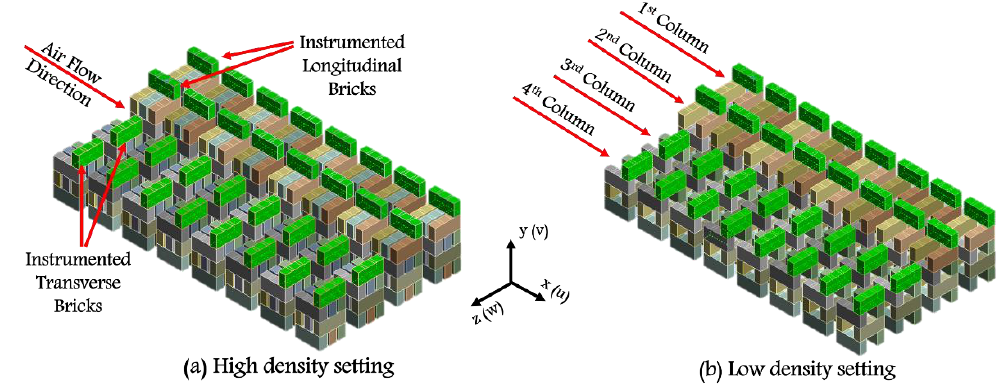
Figure 2. The locations of the instrumented longitudinal and transverse bricks (green-colored bricks) for both the high- and low-density settings.